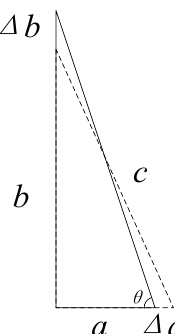
Figure 1. Amplification method based on the Pythagorean theorem.